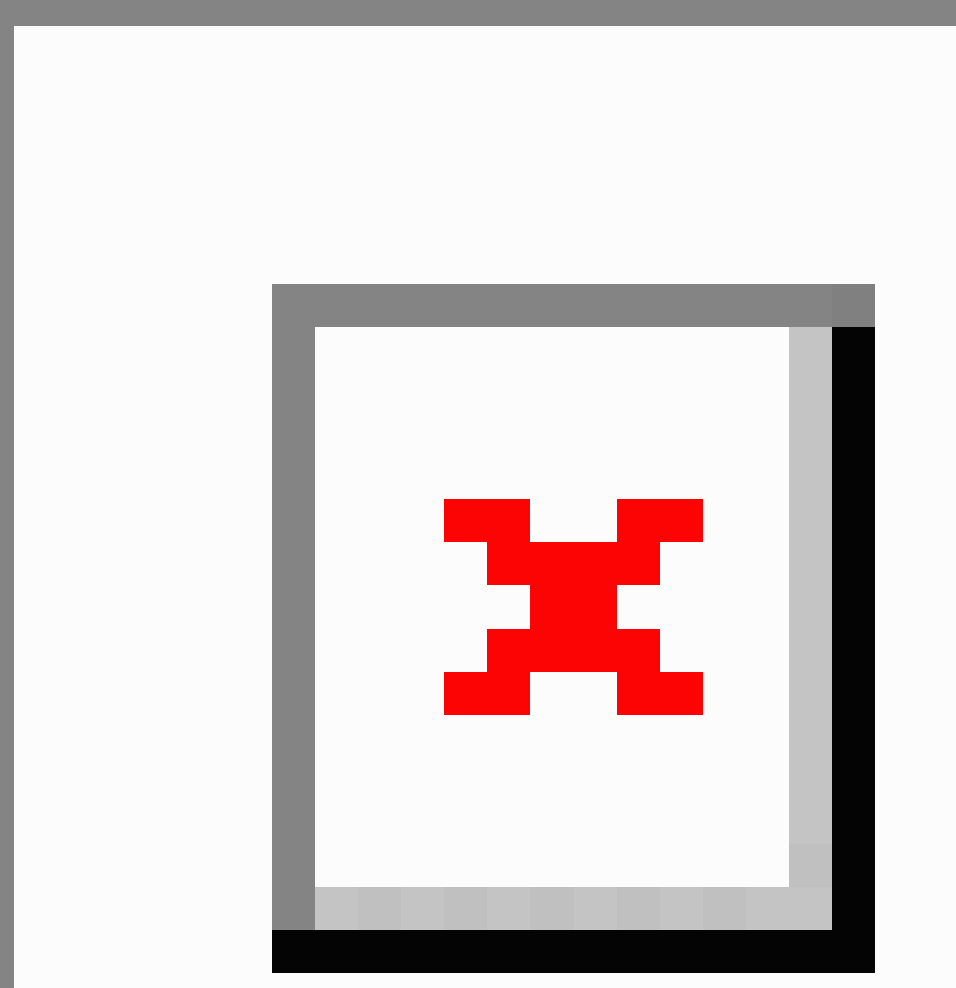
Figure 6. Antenna sites: Manhattan Borough, New York. Black circles indicate gaps in